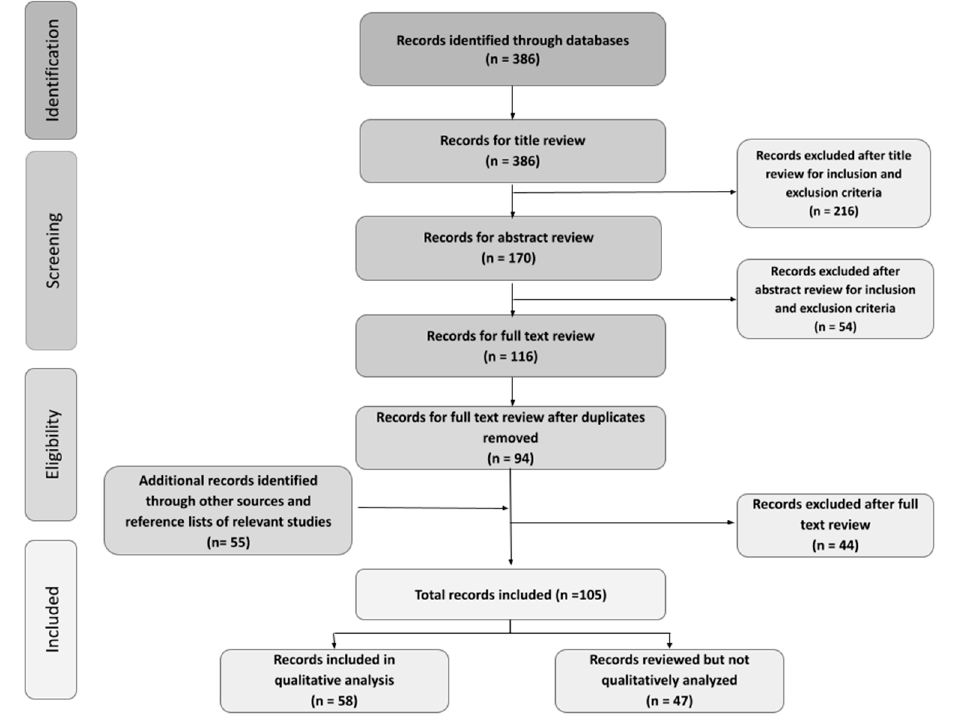
Figure 2. PRISMA diagram of search strategy and analysis.